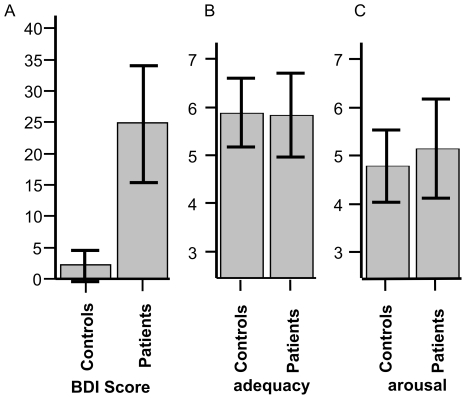
Depression and impact of OPD sentences.A: BDI (Beck Depression Inventory) scores for all subjects and group data. B and C: Scales display whether the OPD sentences were adequate for the participant (B) and whether participants where emotionally aroused by the OPD sentences (C). Error bars show +/− 1 SE.